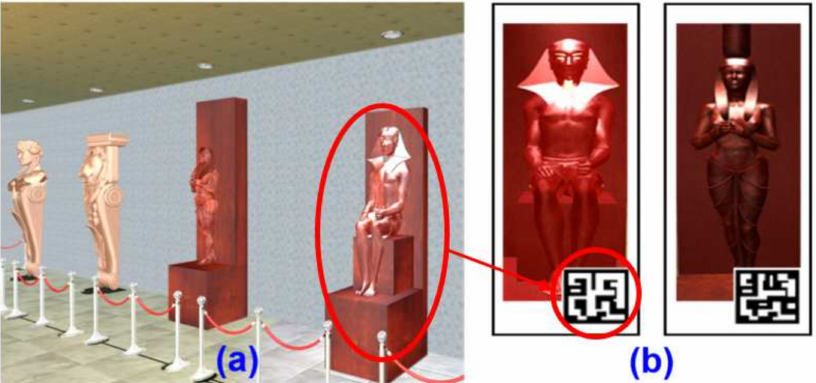
Figure 7. Attention test screen: ( a ) A specific cultural relic will be shown flashing; ( b ) The specific cultural relic needs to be confirmed by scanning the code on the cognitive